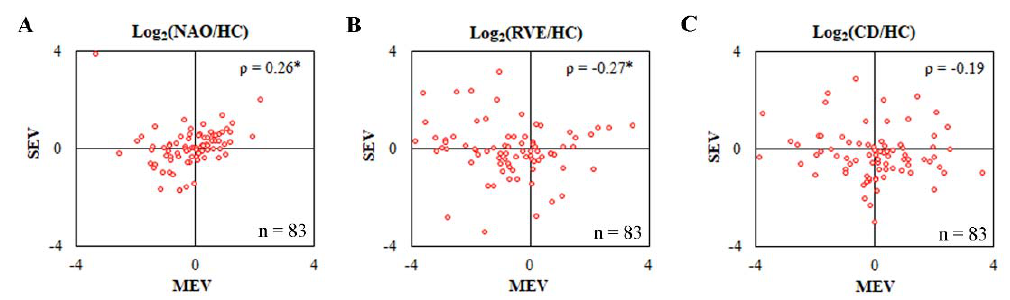
Figure 6. Spearman rank correlation analysis of commonly quantified proteins in MEV and SEV proteomics datasets for three LACI groups; ( A ) NAO, ( B ) RVE, and ( C ) CD. Log ratios of proteins in different outcome groups compared to HC were plotted between MEV and SEV fractions. The plots were presented with an axis value of − 4.0 to +4.0 for better visualization. ρ , Spearman rank correlation; n = 83, * p < 0.05 (two ‐ tailed).